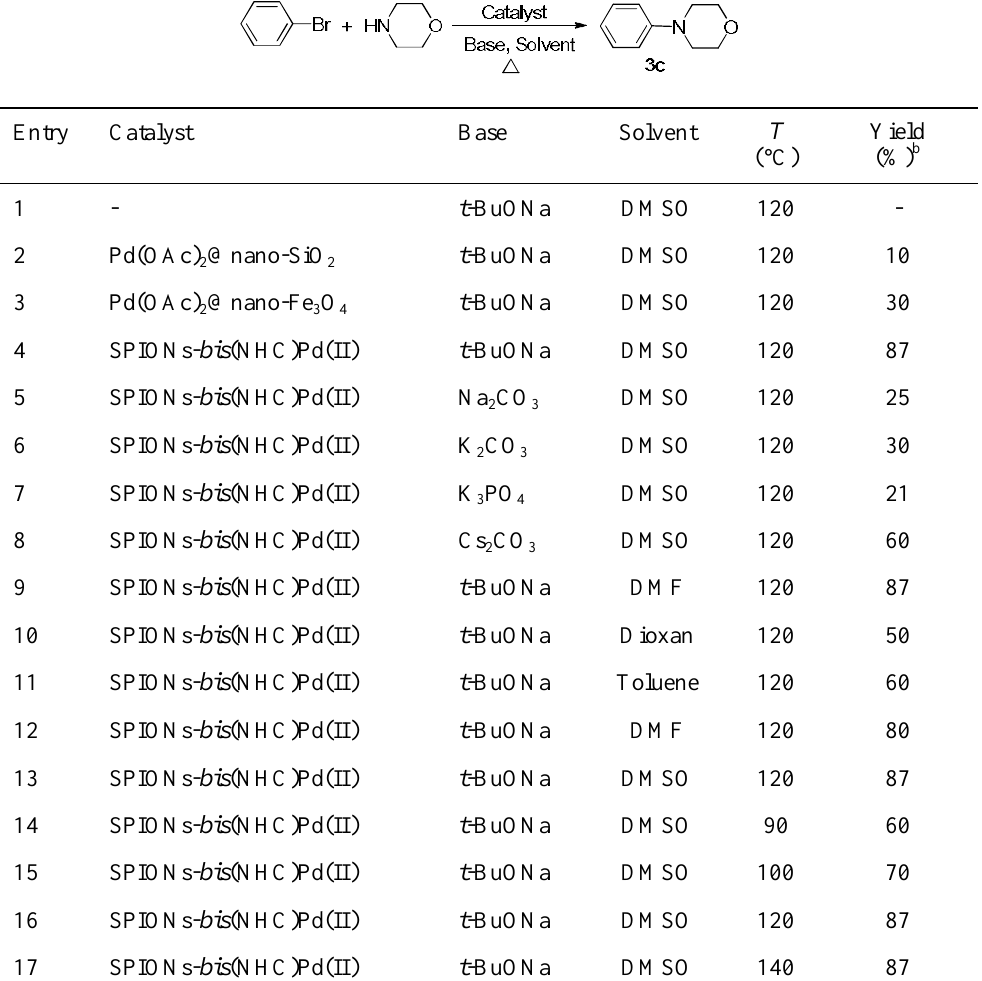
Table 1. Optimization of Buchwld-Hertwig Reaction for the Synthesis of 3c Under Different Conditions